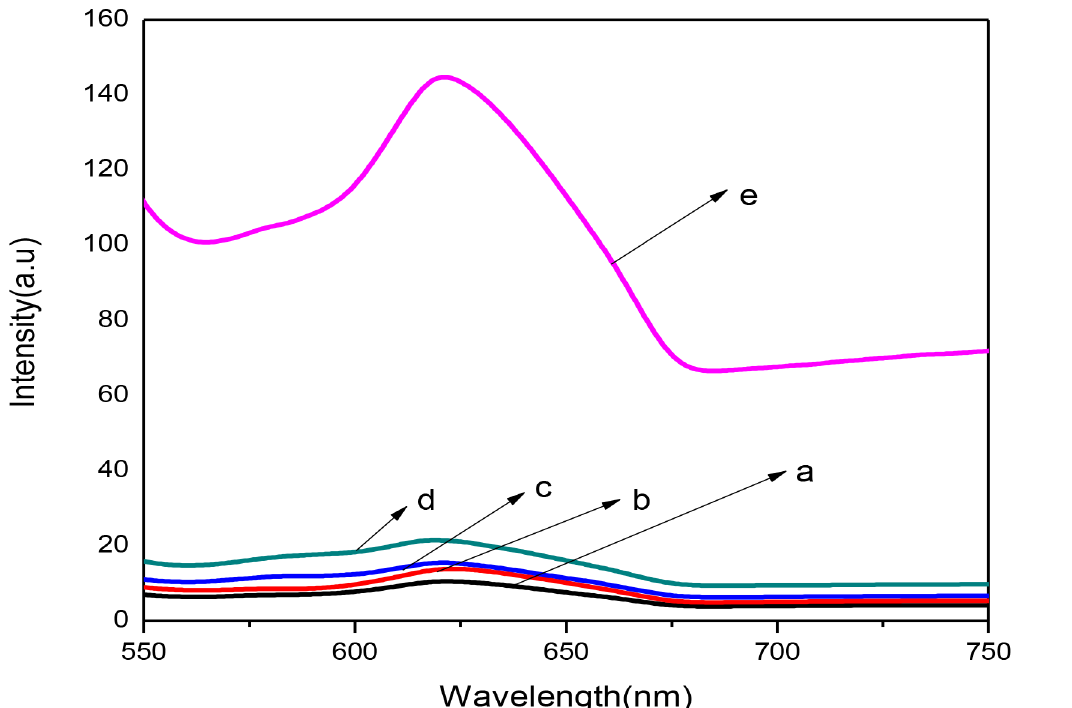
Fig 5. PL spectrum of MWCNTs (a), MWCNTs/TiO 2 nanocomposites (b)(1:1), (c)(1:2), (d)(1:3) and (e)TiO 2 -p25.